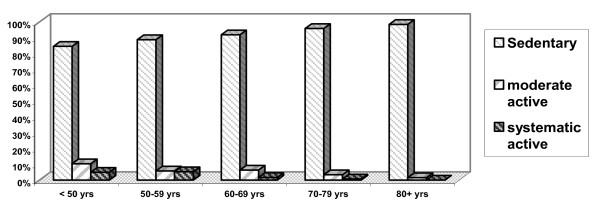
Weekly physical activity according to age decade. This figure depicts a categorization of weekly physical activity frequency according to age-decade only. The cut-off decade for reduction of physical activity in women was found 60-69 decade.